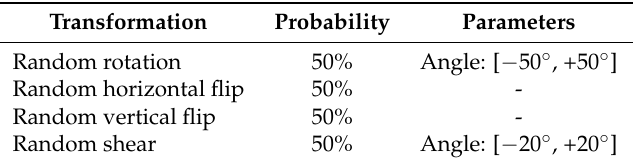
Table 3. Data augmentation